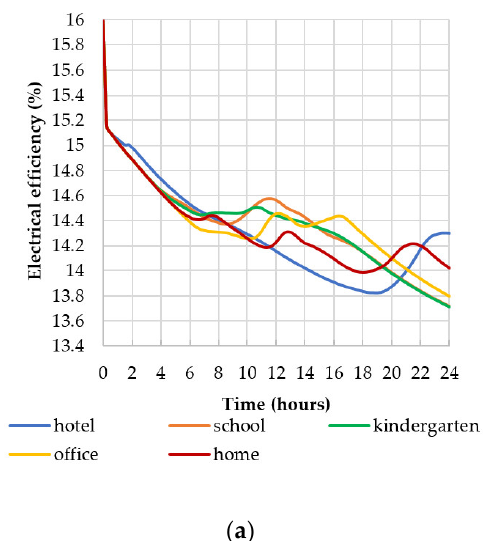
Figure 14. Instantaneous power versus PVT inlet temperature. 3.6. Discussion The parametric analysis revealed that the flow rate at the outlet of the tank is the most impactful factor on the electrical efficiency, and secondly ranked is the tank volume, as shown in Figure 15. This